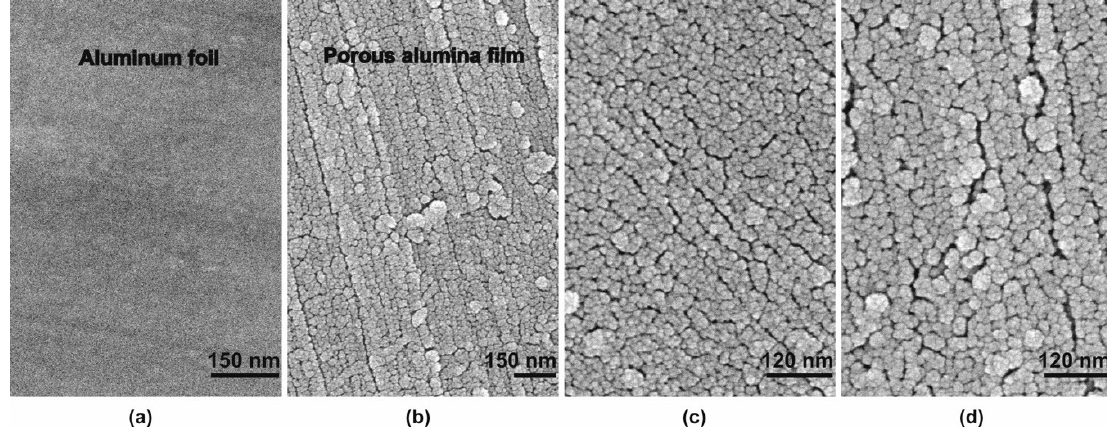
Figure 6. SEM images of the surface of ( a ) initial aluminum foil and porous alumina films fabricated by low temperature sulfuric acid anodizing at current densities j a of ( b ) 10, ( c ) 4.9, and ( d ) 0.9 mA ∙ cm − 2 and sulfuric acid concentrations of ( b ) 2.0 and ( c , d ) 0.4 M.